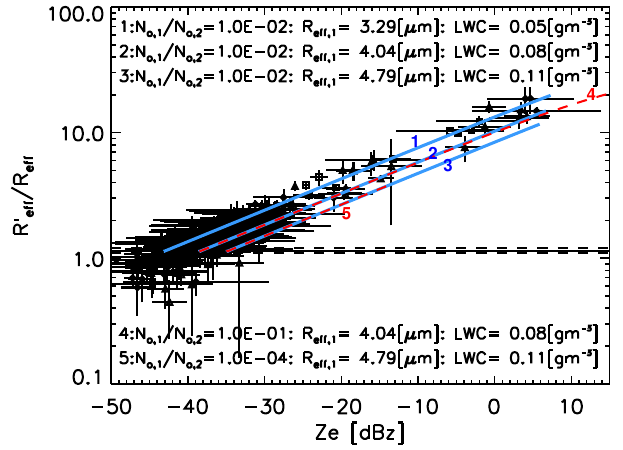
/R eff obtained by combining the lidar Figure B2. Values of R (cid:48) eff inversion results and the observed cloud-base reflectivities. The dif- ferent symbol types correspond to different time periods as de- scribed in Fig. B1. The horizontal lines correspond to the uni-modal limit (Eq. 8) with γ = 9 ± 4). The light-blue lines correspond to the relationships predicted using Eqs. (B5) and (B6) found by varying R m,2 with the other parameters fixed to their the indicated respec- tive